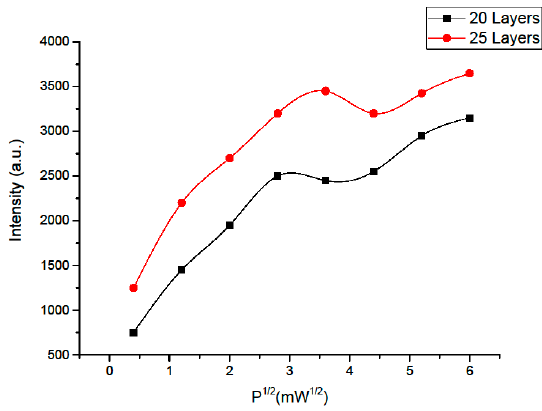
Figure 8. Dependence of the EPR signal intensity on P 1/2 .